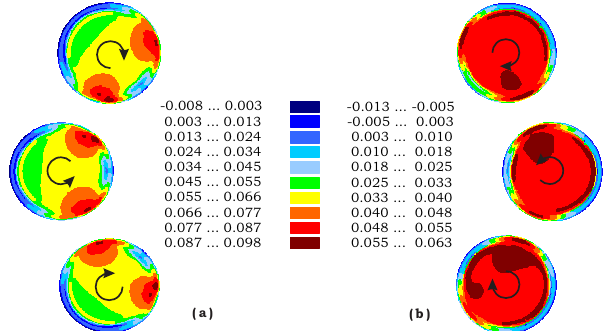
Figure 19. Nondimensional (with respect to Ω R ) induced velocity distribution over Octocopter propeller discs in hover; ( a ) propellers are in-phase; ( b ) propellers are